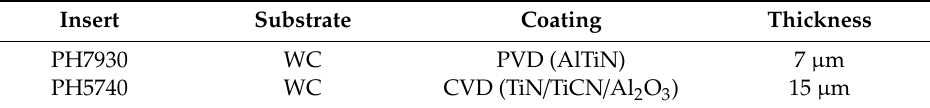
Table 1. Some of the main characteristics of the two insert types.